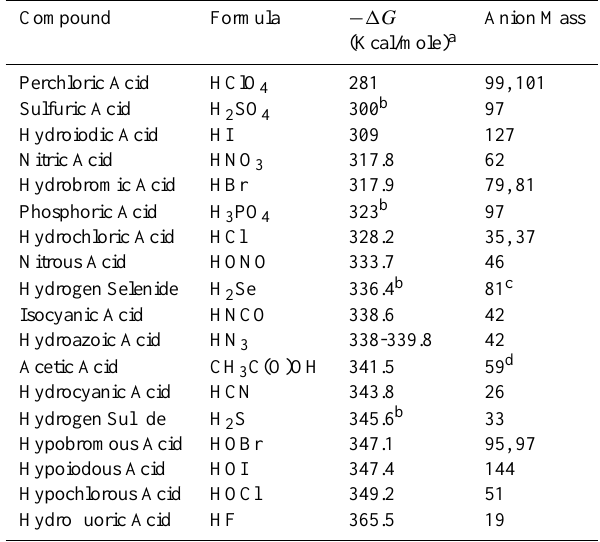
Table 1. Gas phase acidities and anion masses of inorganic acids and compounds of potential interest.